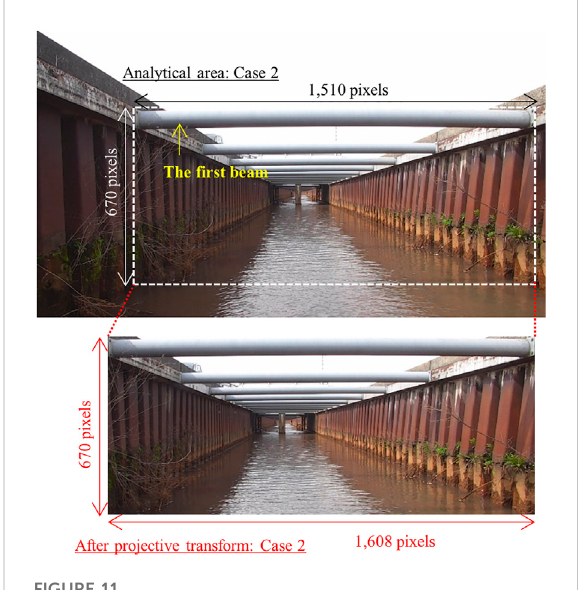
FIGURE 11 A projective transform to correct image rotation in Case